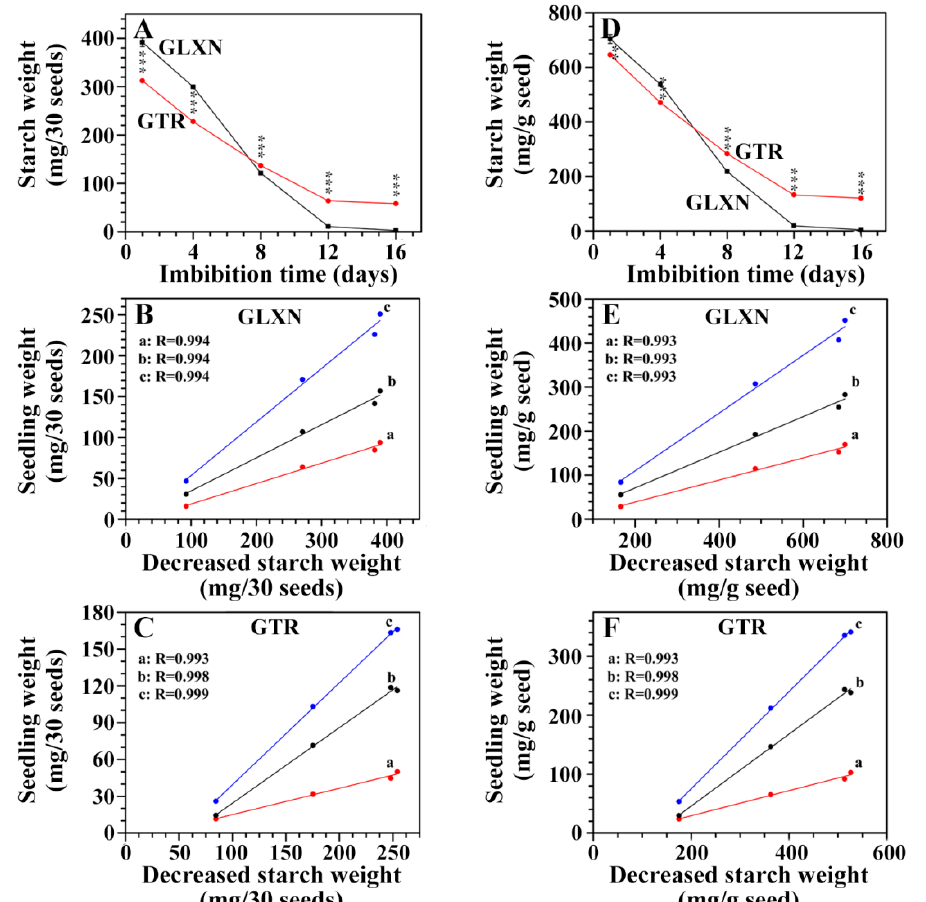
Figure 5. The starch weight in seeds and its relationship with seedling weight during seedling growth. ( A , D ): dry weight of starch in seeds. The values are means ± SD ( n = 3). * The GTR data are significantly different compared with the GLXN data at the same imbibition time (** for p < 0.01 and *** for p < 0.001). ( B , C , E , F ): the relationships between the decreased starch weight and root dry weight (a), shoot dry weight (b), and seedling dry weight (root weight + shoot weight) (c). The R indicates the regression coefficient.